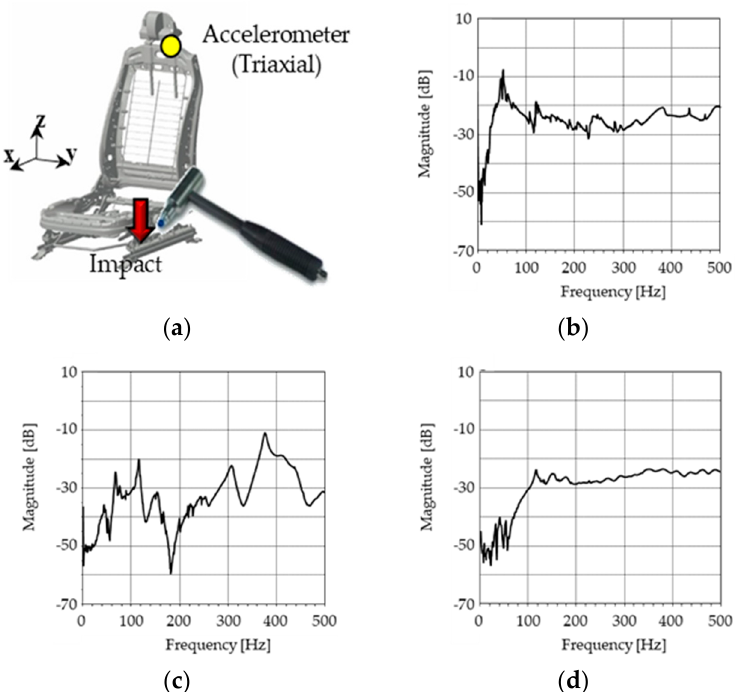
Figure17. Frequencyresponseatthehead-reststay( a )Experimentalsetupformodaltesting: ( b ) x -direction, Figure 17. Frequency response at the head-rest stay ( a ) Experimental setup for modal testing: ( b ) x - ( c ) y -direction, ( d ) z direction, ( c ) y-direction, ( d ) z -direction.